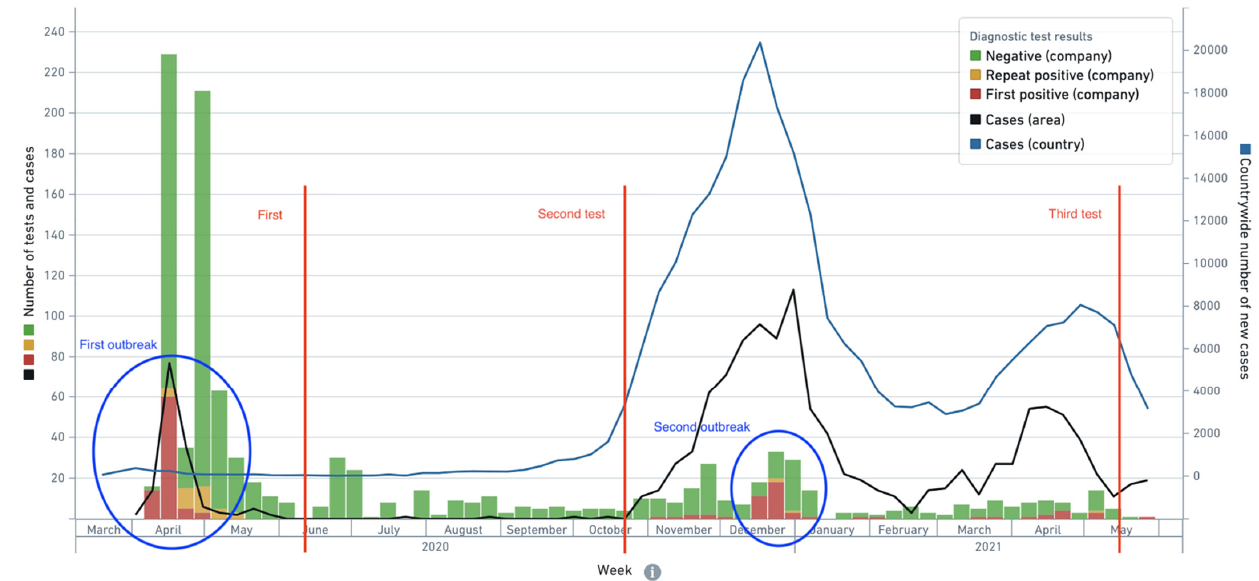
Figure 1. Epidemiological context in the country/local area and the timing of outbreaks of SARS-CoV-2 infection and serological tests in the company. There were two major outbreaks in the company (blue circles), one in April 2020 (two months preceding the first serological test) and another in December 2020 (between the second and third serological tests). There were no cases recorded in the company between the first and the second serological test. Source: VDV IS, the Lithuanian Statistics Department.